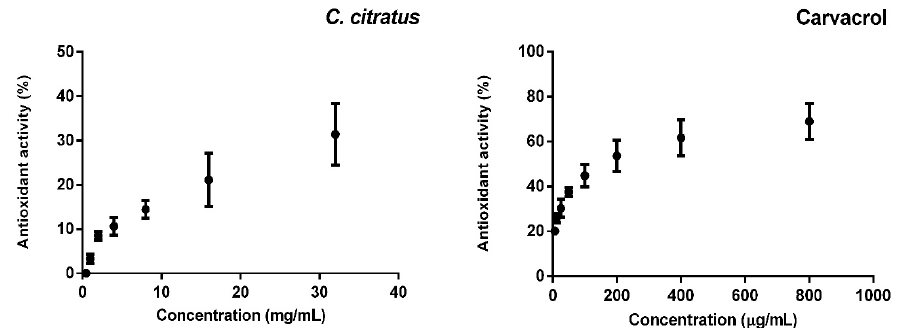
Figure 2. Antioxidant activity by the DPPH of Cymbopogon citratus essential oil and carvacrol. All tests were run in three independent experiments (n = 3) and results expressed as mean values with standard deviation (± SD).